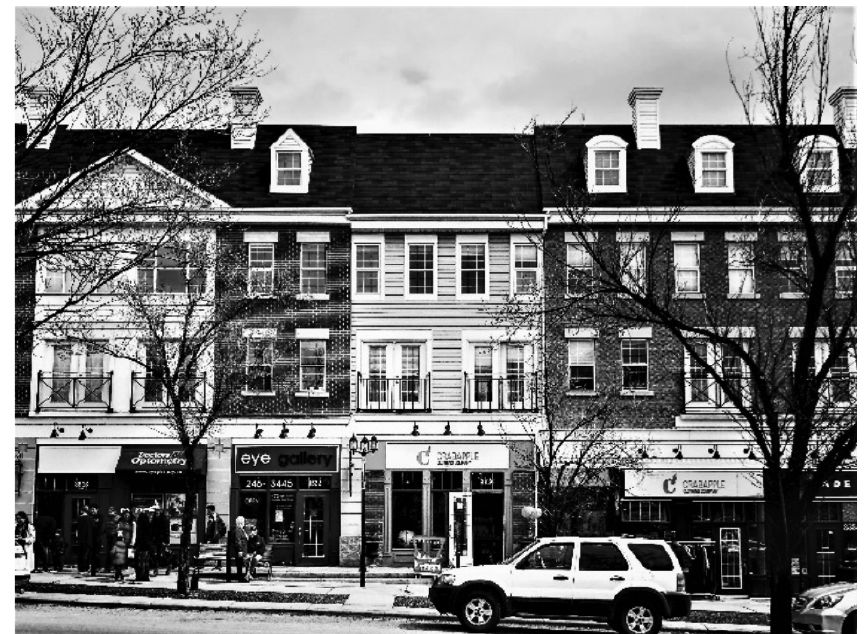
Figure 1. New Urbanism as neo-traditional vertical mixed use: Garrison Woods in Calgary, Alberta, Canada, in April 2019. Source: